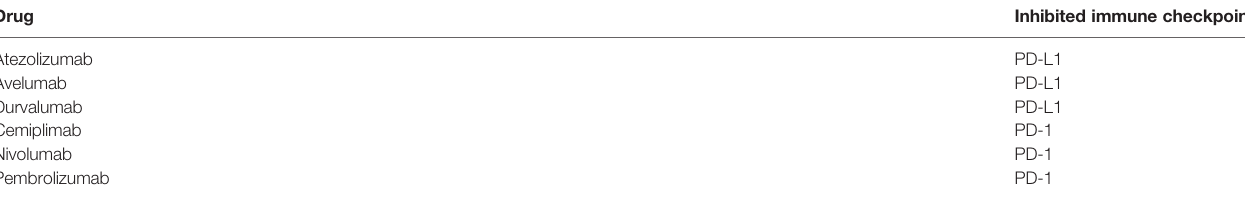
TABLE 2 | Six PD-1/PD-L1 inhibitors approved by the Food and Drug Administration (FDA). Drug